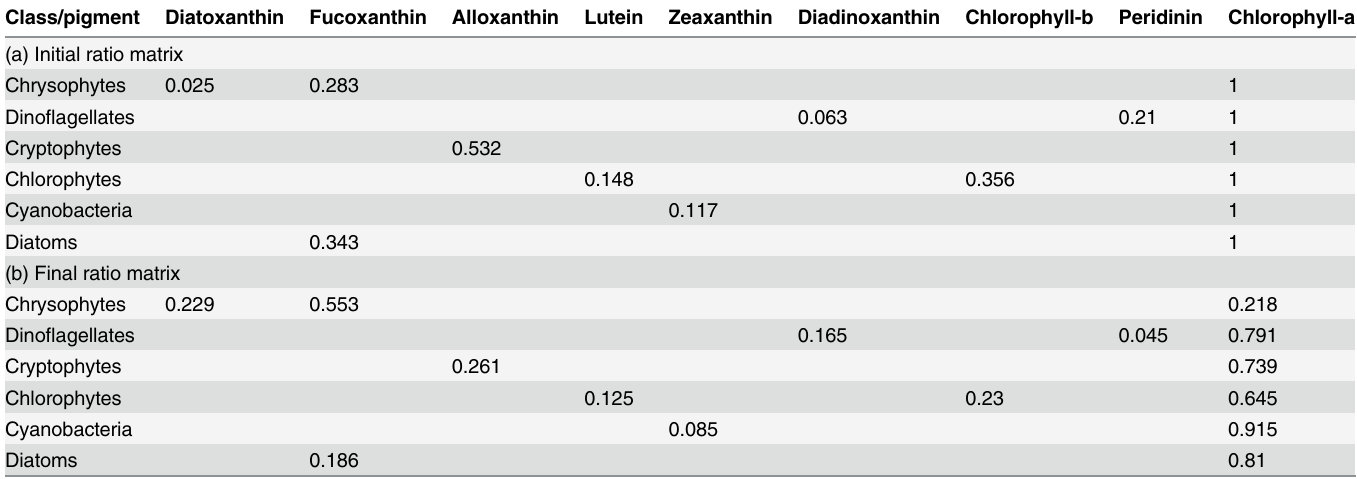
Table 2. Marker pigment:Chl a ratios used for CHEMTAX calculations: a) initial ratio matrix, b) final ratio